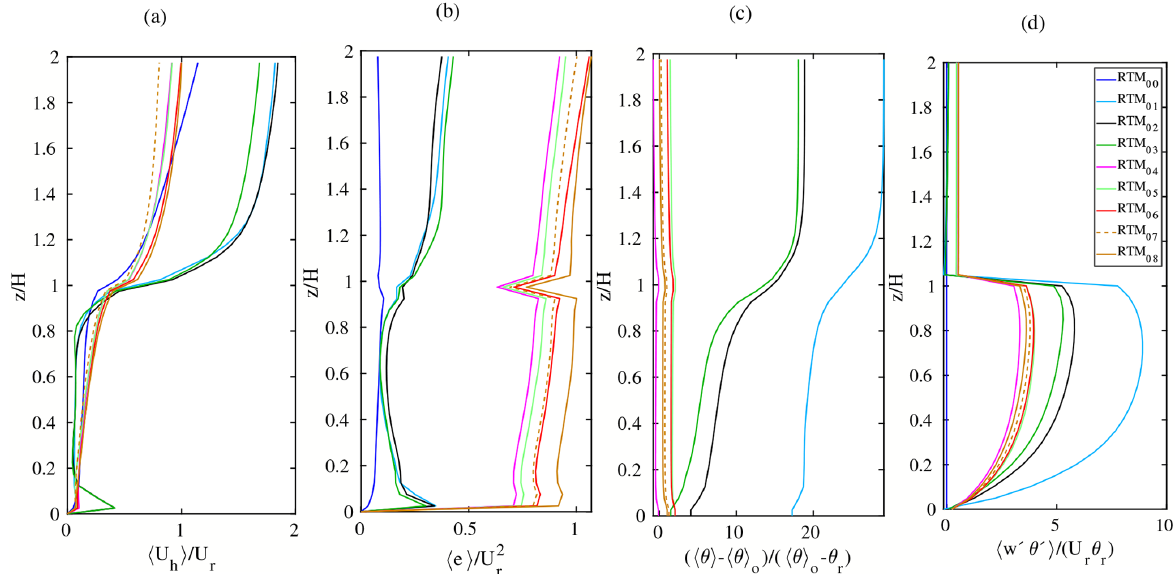
Figure 21. Horizontal- and time-averaged (1h) vertical profiles of the simple urban configuration at 10:00LST of (a) horizontal wind speed (cid:104) u h (cid:105) = (u 2 + v 2 ) 1 / 2 , (b) turbulent kinetic energy (cid:104) e (cid:105) , (c) normalized vertical potential temperature (cid:104) θ (cid:105) deviation from the near-surface potential temperature (cid:104) θ 0 (cid:105) , and (d) normalized vertical turbulent flux of potential temperature (cid:104) w (cid:48) θ (cid:48) (cid:105) . Each quantity is normalized by its relevant combination of velocity ( U r ), temperature ( θ r ), and height scale ( H ). The reference velocity and temperature are the respective values at 2 H and the height scale is the building height.